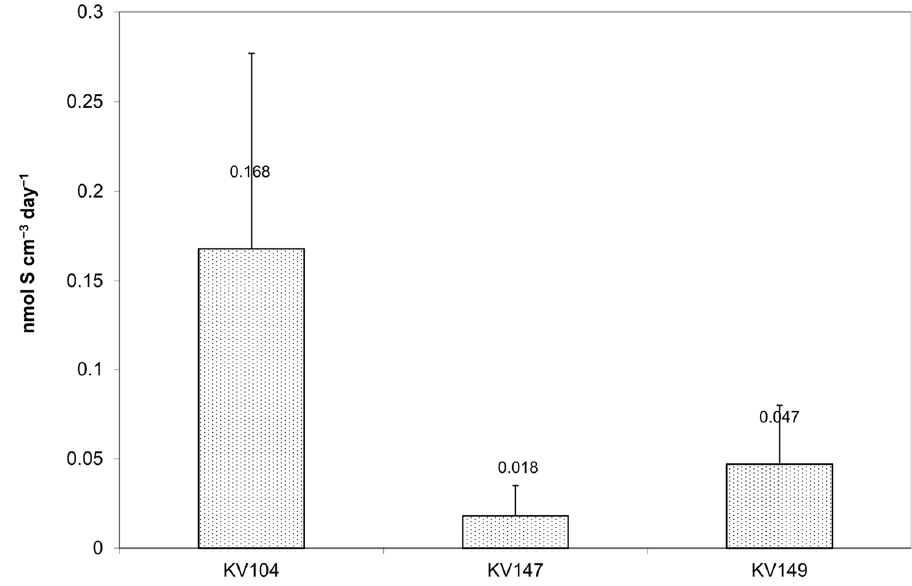
Figure 4. The sulfate reduction rate (SRR) measured in samples KV104, KV147, and KV 149. The vertical bars show the standard deviation.